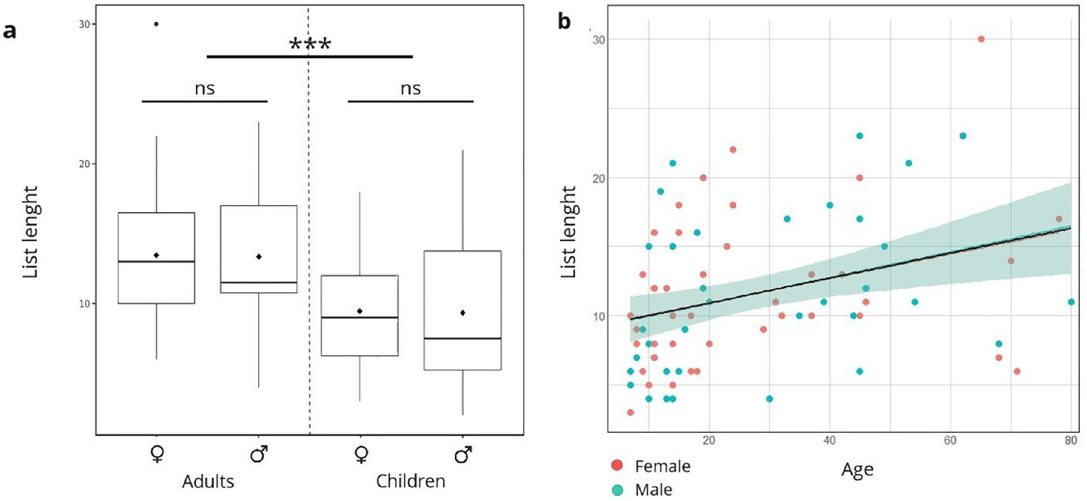
Fig 3. Gender and life stage effect on the number of WEPs cited: a. comparison of the mean WEP species richness cited by subsamples of informants, b. linear correlation between WEP list length and age (female = red dots and male = blue dots). ns = non-significant.